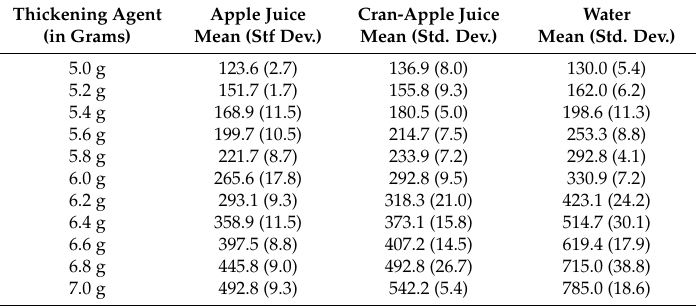
Table 1. Viscosity measurements in cP for the beverages mixed with incremental increases in the amount of instant thickening